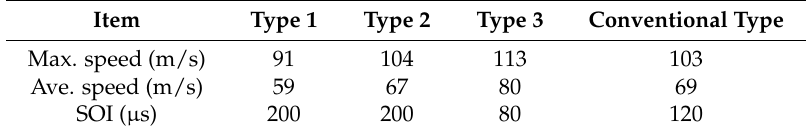
Figure 15 . Comparison of spray speed with various DPIs. Table 8. Comparison of spray characteristics with various DPIs.